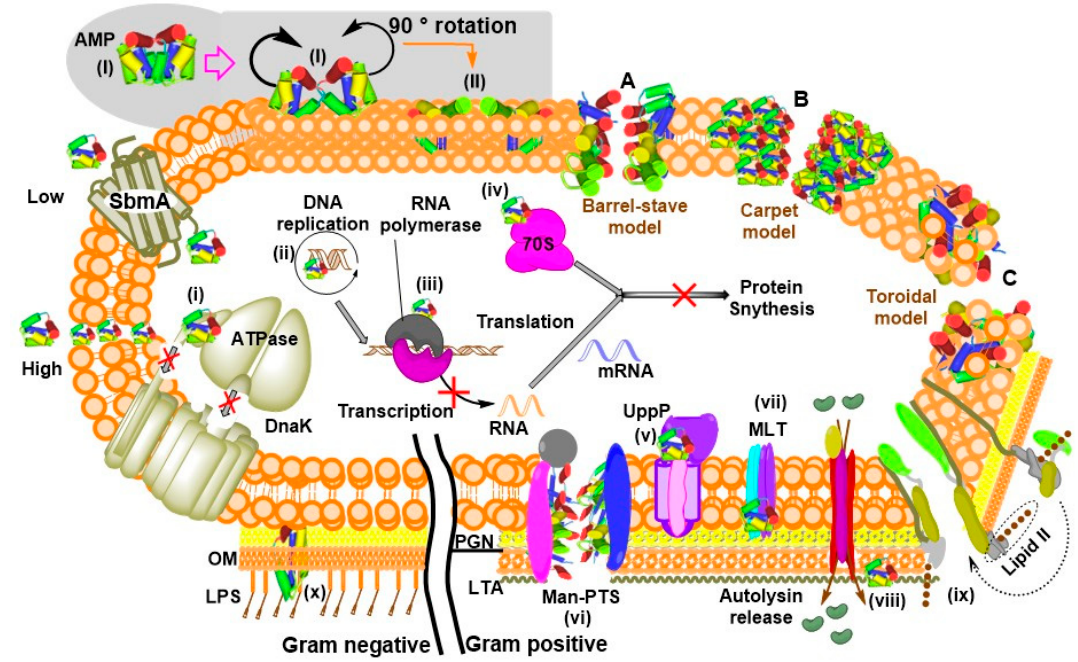
Figure 5. Membrane penetration mechanisms and mode of action of AMPs. Shaded region illustrates a structural model of the molecular interaction of an AMP with the phospholipid bilayer. A , Barrel-stave pore membrane disruption mechanism where the peptides line the hollow pore, and are oriented parallel to the phospholipid chains. B , Carpet mechanism where the peptides have a detergent-like effect on the membrane. C, Toroidal pore where the lumen of the pore constitutes a mixture of peptide and phospholipids resulting from perpendicular insertion of the peptides in the bilayer. Non-invasive mechanisms of AMPs include binding to: ( i ) DnaK, ( ii ) duplex DNA helices ( iii ) RNA polymerase, ( iv ) 70S ribosome, ( v ) undecaprenyl pyrophosphate phosphatase (UppP), ( vi ) mannose phosphotransferase system (Man-PTS), ( vii ) maltose transporter (MLT), ( viii ) Lipoteichoic acid (LTA), ( ix ) lipid II, inhibiting cell wall biosynthesis, and ( x ) LPS. The abbreviations PGN, peptidoglycan; OM, outer membrane.